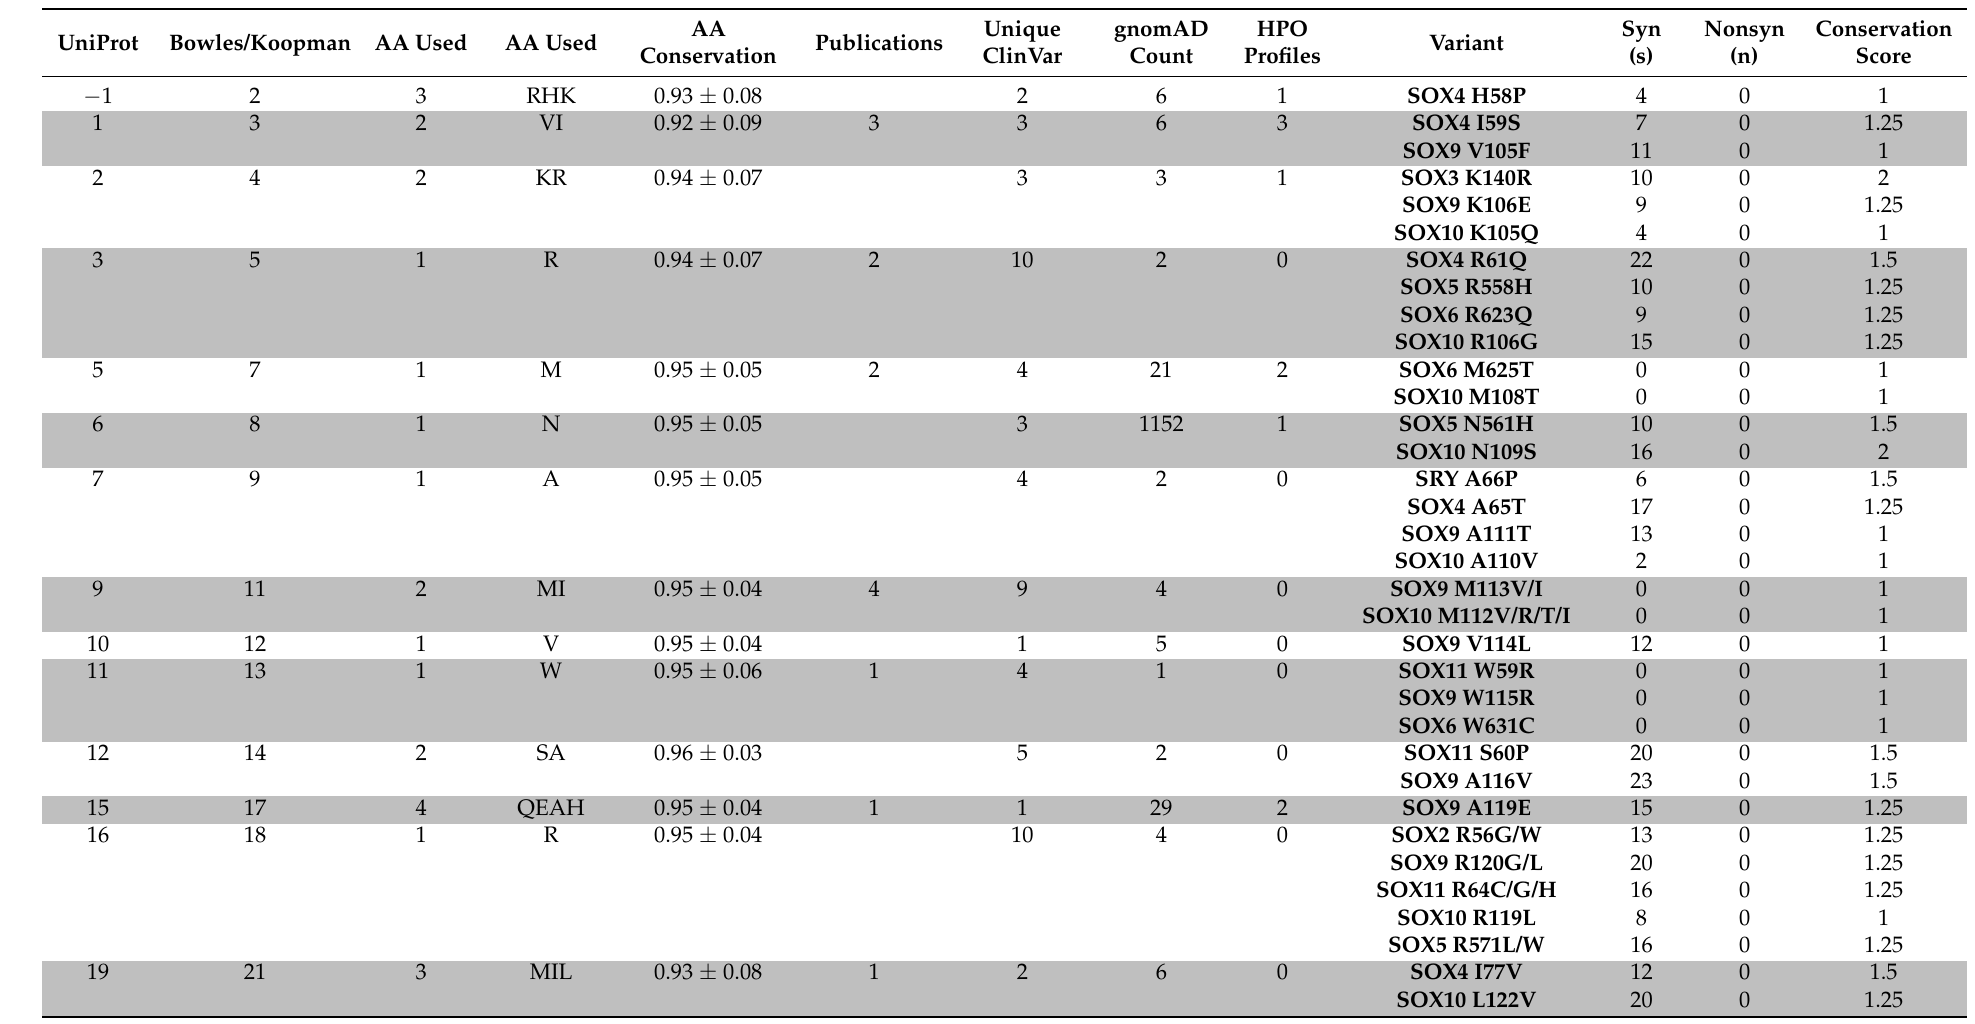
Table 3. ClinVar variants within the HMG box using UniProt or Bowles/Koopman numbering. Rotating white to gray indicates different amino acids with multiple variants for